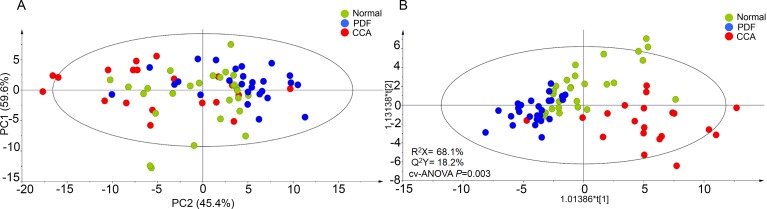
Biomarker qualification and multivariate analysis.(A) and (B) PCA and O-PLS-DA score plots of MRM results of urinary candidates that show sample differentiation; normal pathology (green), PDF (blue) and CCA group (red).